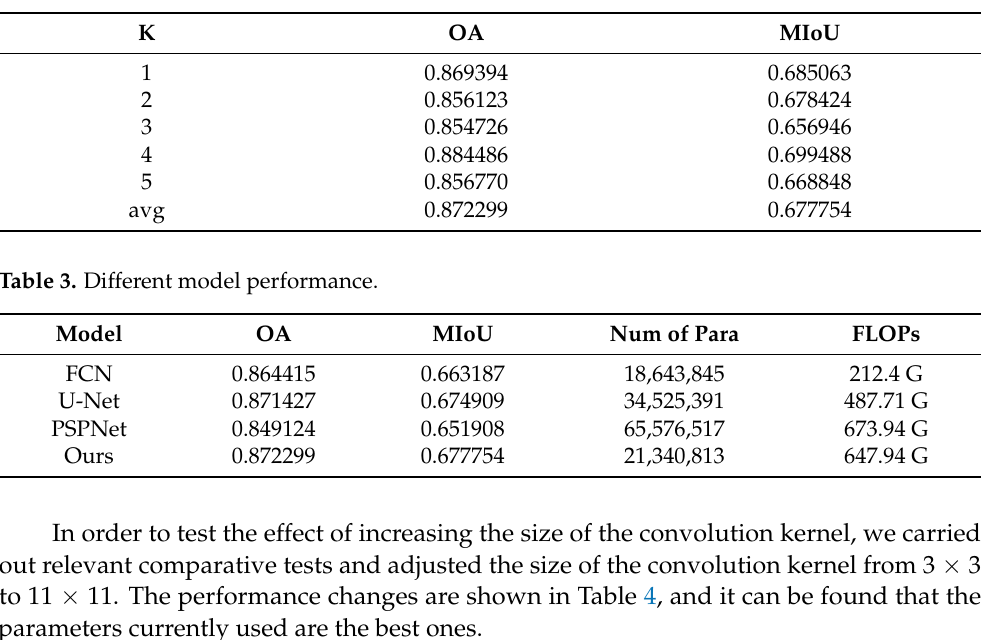
Table 2. K-fold cross validation (K = 5).